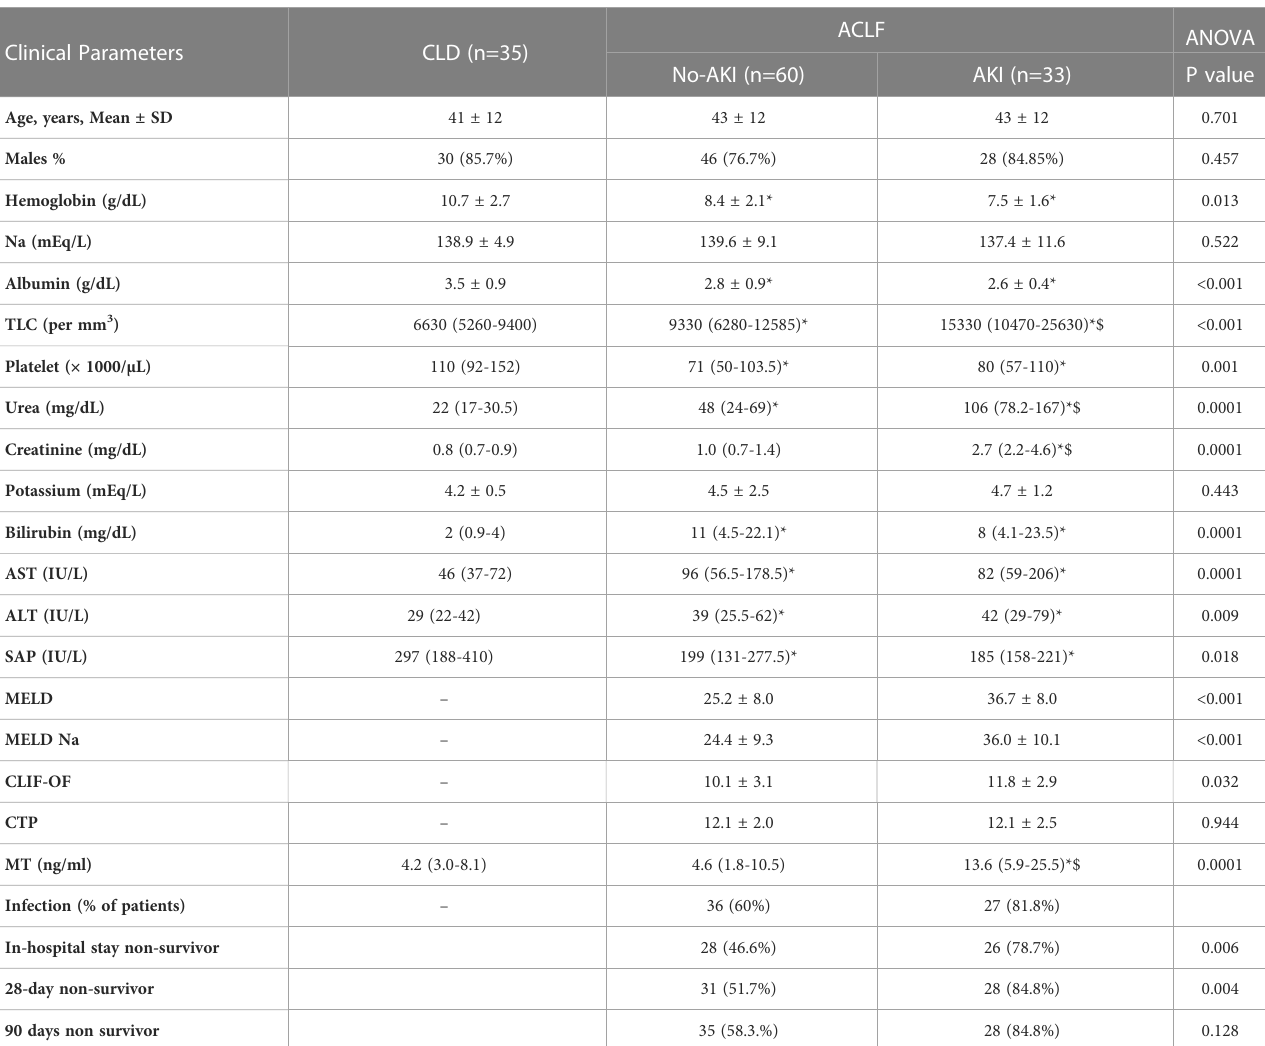
TABLE 3 Baseline characteristics across groups.